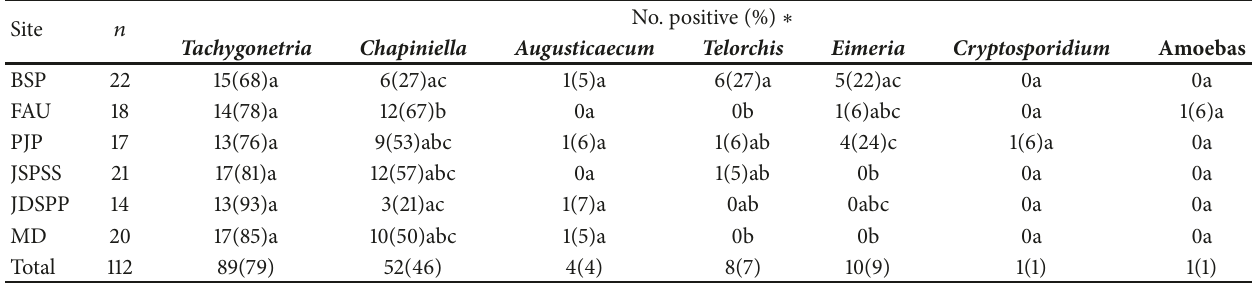
Table 1: Intestinal parasite eggs and oocysts in adult and subadult gopher tortoise ( Gopherus polyphemus ) fecal samples from six populations in South